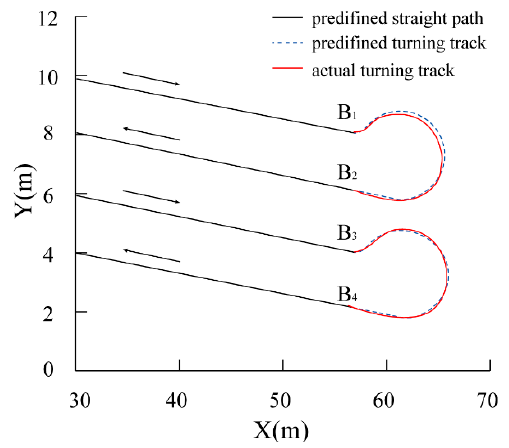
Figure 11. Tracking curve of the headland turning.